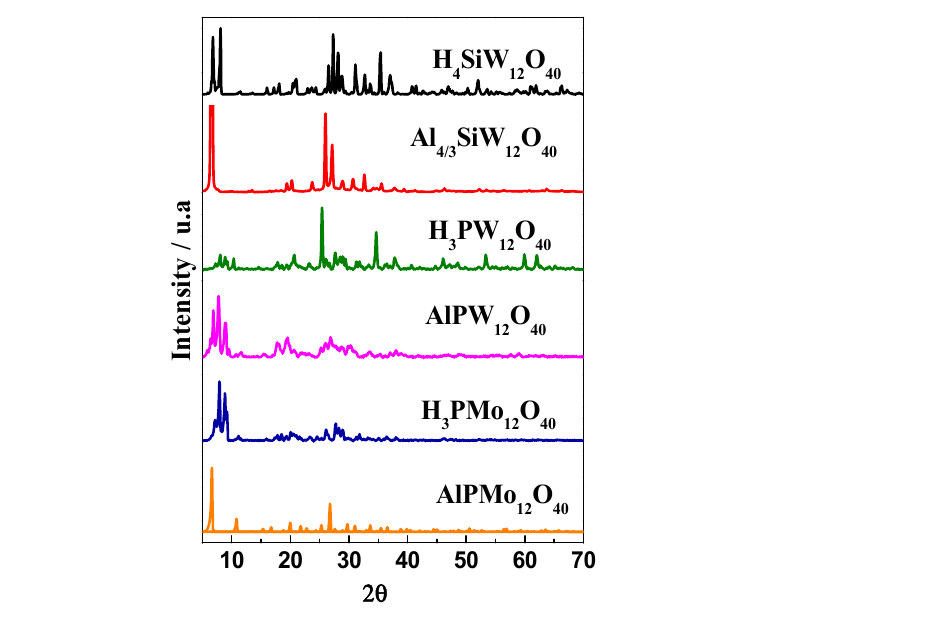
Figure 7. Powder XRD patterns of phosphotungstic, silicotungstic, and phosphomolybdic acid and their aluminium-exchanged salts (adapted from refs. [34,35]).